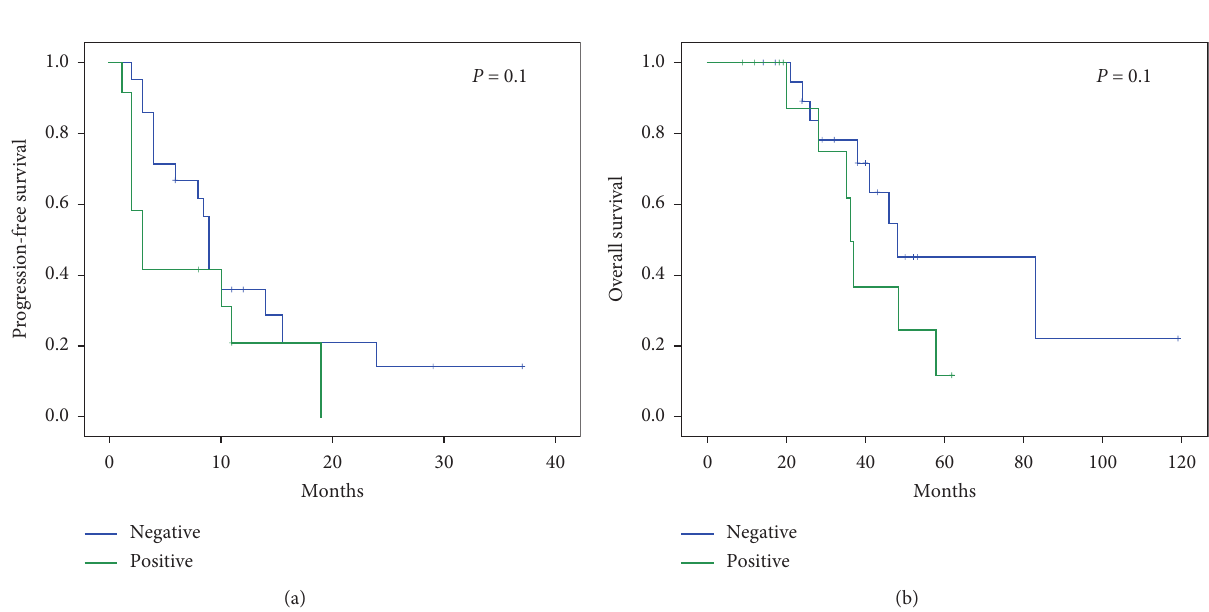
Figure 2: Progression-free survival (a) and overall survival (b) in lipocalin-2-positive and lipocalin-2-negative